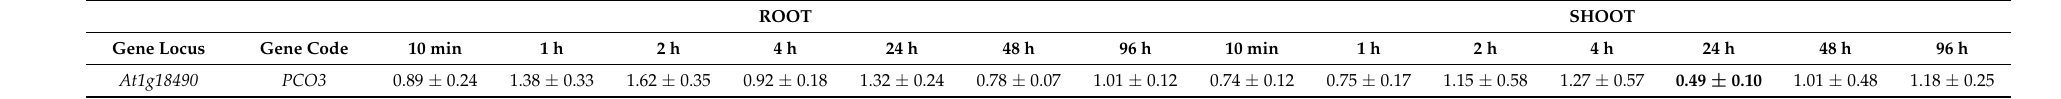
Table 5. Group E. Genes downregulated in shoots at 24 h. Genes selected based on a fold change ≥ 2 or ≤ 0.5 in at least one time point. Values are expressed as the mean and standard deviation ( ± ), values with a fold change ≥ 2 or ≤ 0.5 are indicated as boldfaced numbers. ROOT